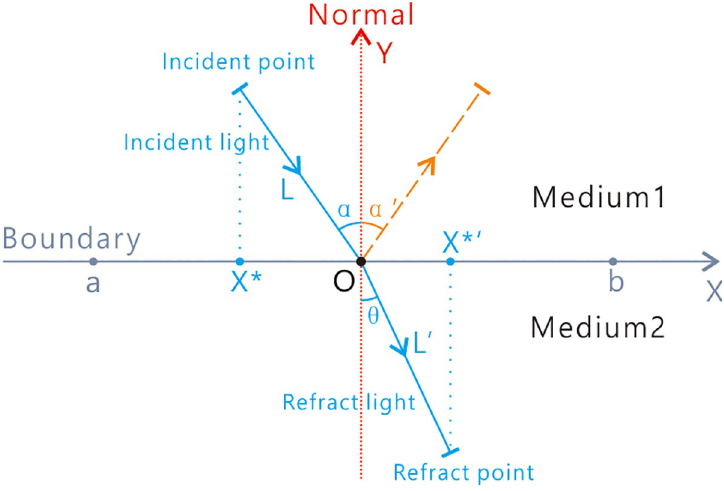
Fig 6. The principle of refraction